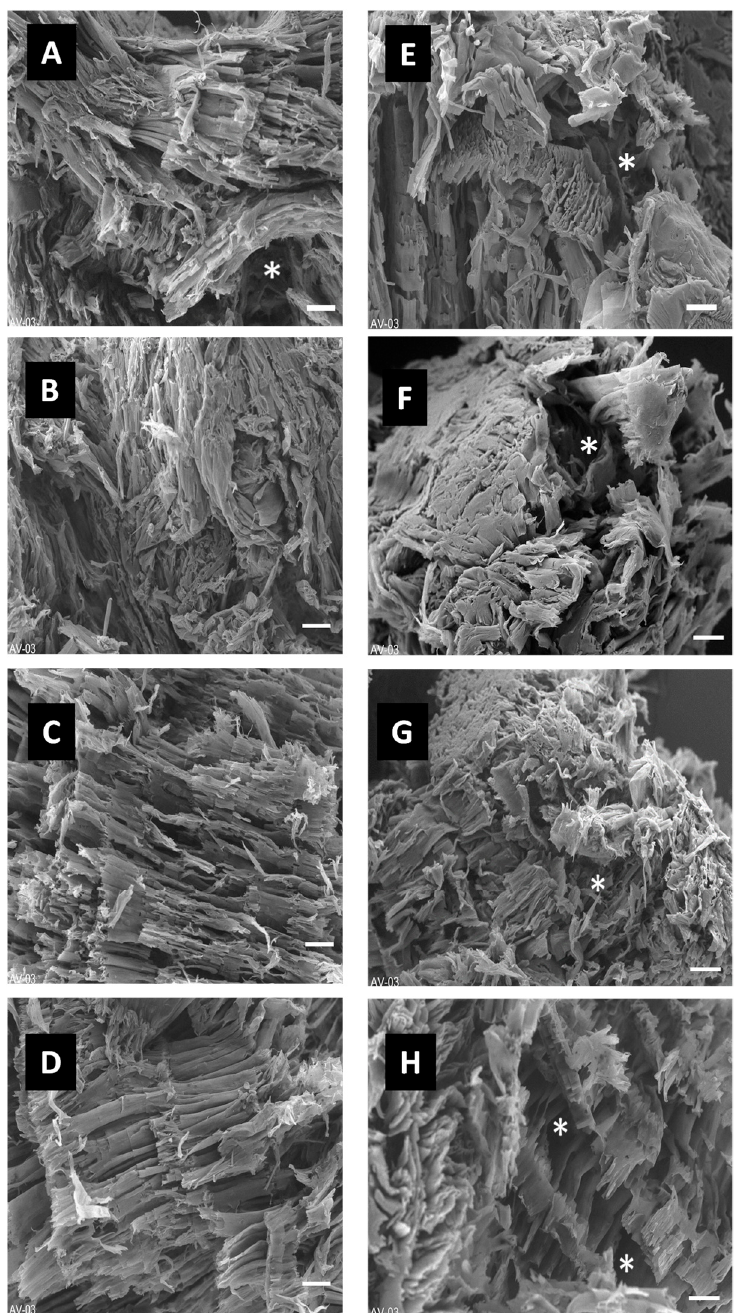
Figure 4. SEM images of cryogel sca ff olds: ( A ) 100:0 0B, ( B ) 100:0 1B, ( C ) 100:0 2B, ( D ) 100:0 3B, ( E ) 50:50 0B, ( F ) 50:50 1B, ( G ) 50:50 2B, and ( H ) 50:50 3B. Scale bars are equal to 100 µm. * indicates the macro-pores.